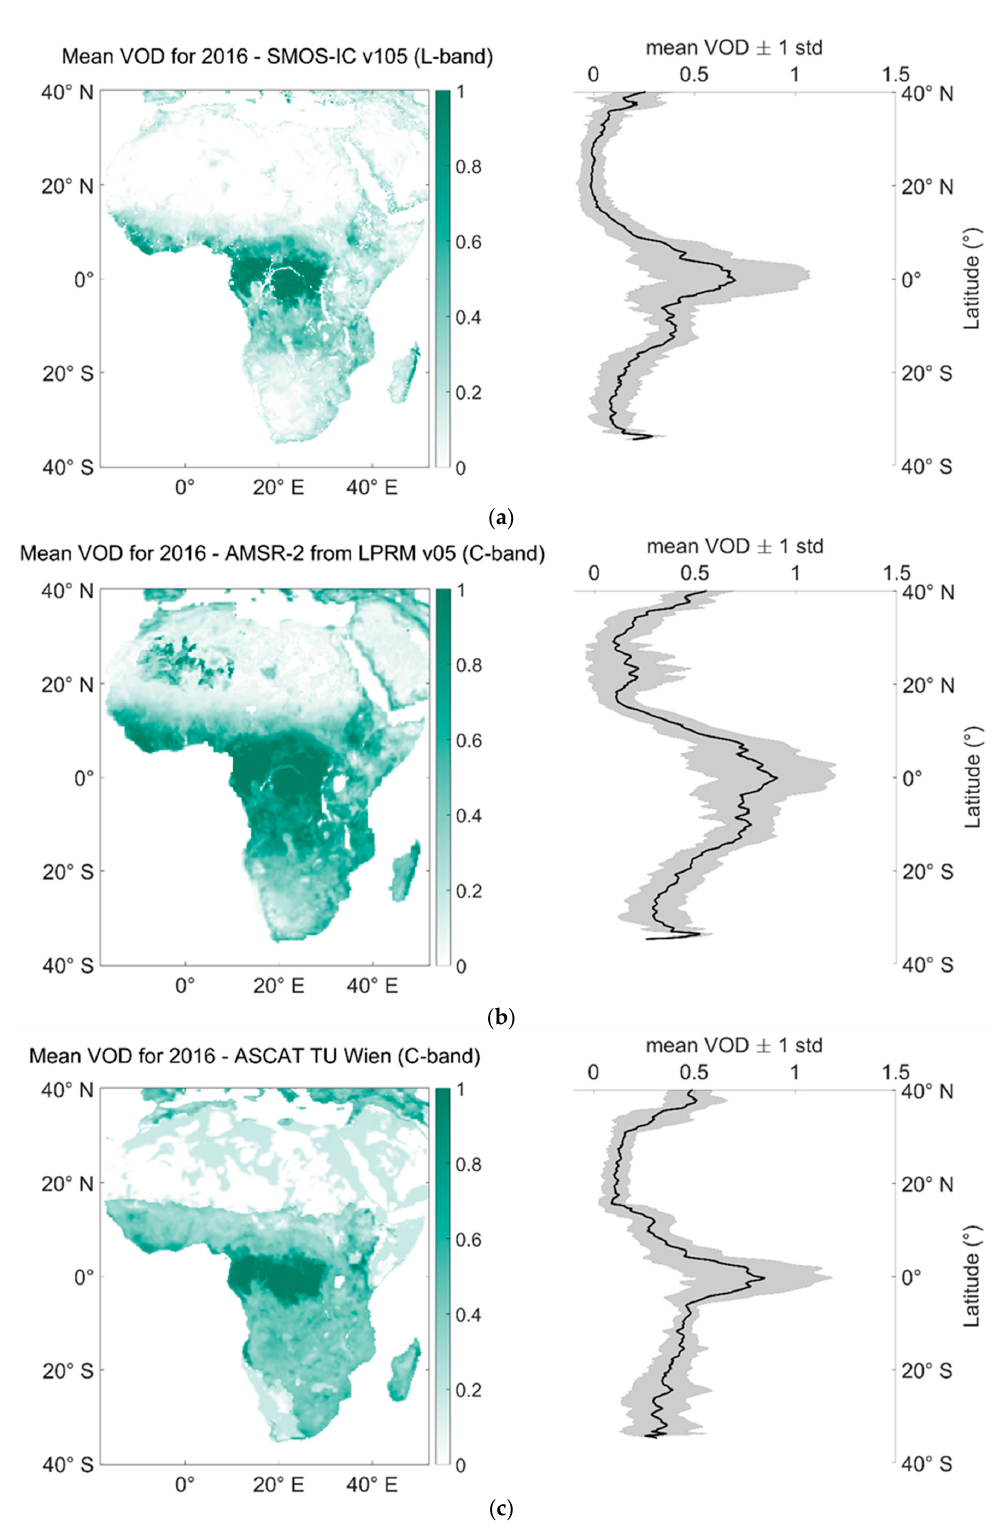
Figure 4. ( a ) Average Vegetation Optical Depth (VOD) over Africa from SMOS-IC v105 for 2016 (left) and corresponding zonal average (right); ( b ) Same for AMSR-2 from Land Parameter Retrieval Model (LPRM) v05; ( c ) Same for Advanced Scatterometer (ASCAT) from TU